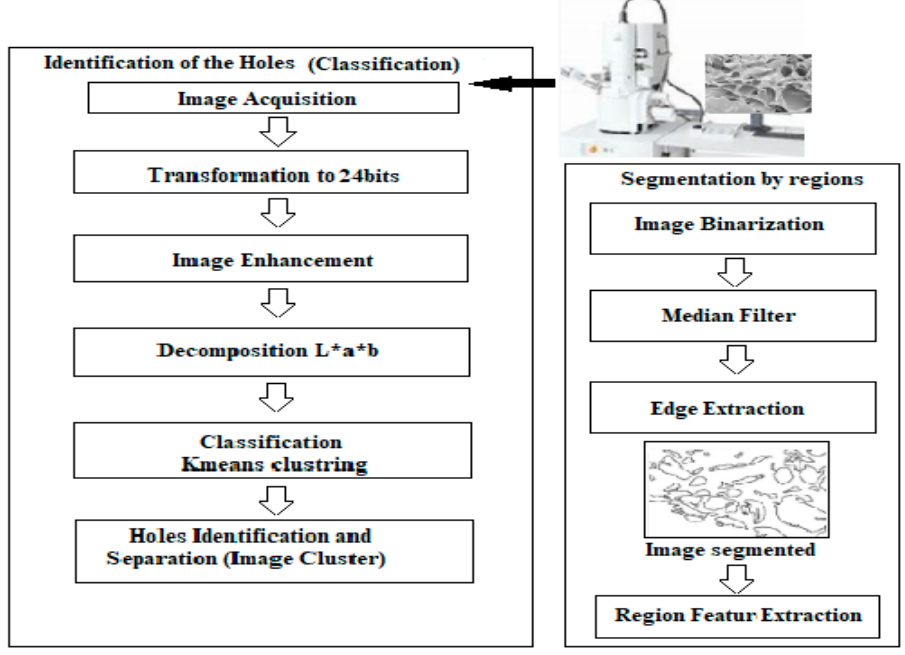
Figure 2. The proposed flow chart diagram of the image processing steps.